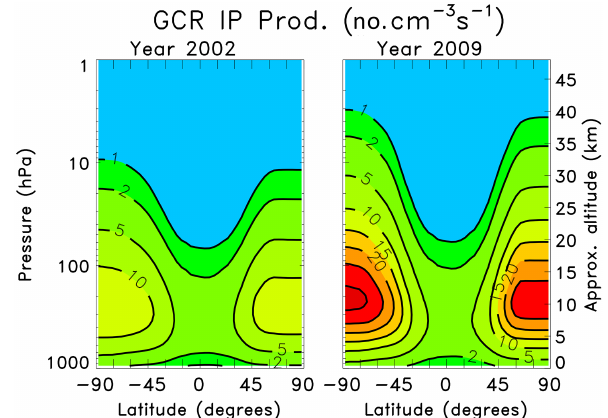
Figure 1. NAIRAS model computed GCR annual average ioniza- tion rates for years 2002 (left) and 2009 (right). Contour intervals are 1, 2, 5, 10, 15, 20, 25, and 30 (#cm − 3 s − 1 ).